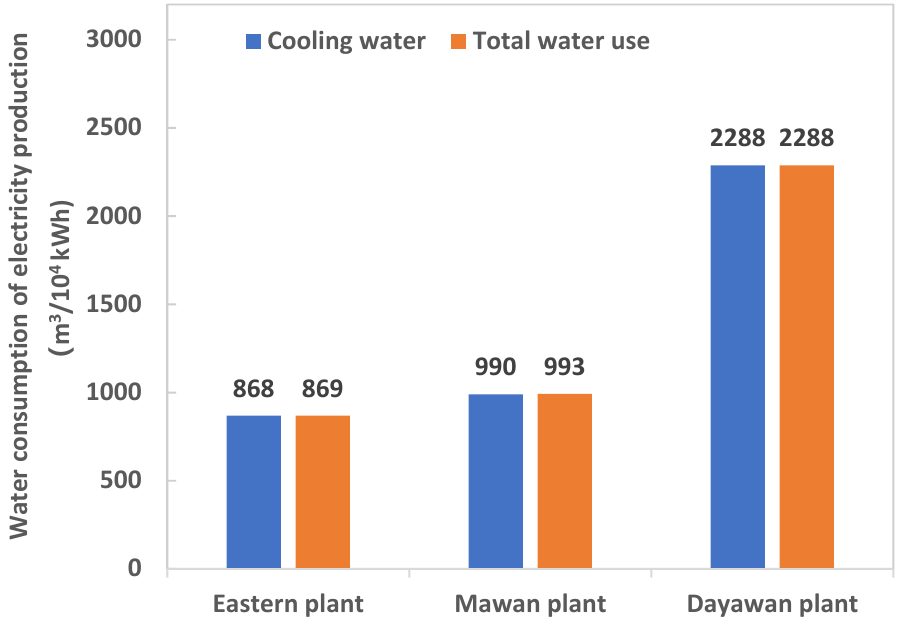
Figure 13. Water consumption of power plants using an open cooling system.